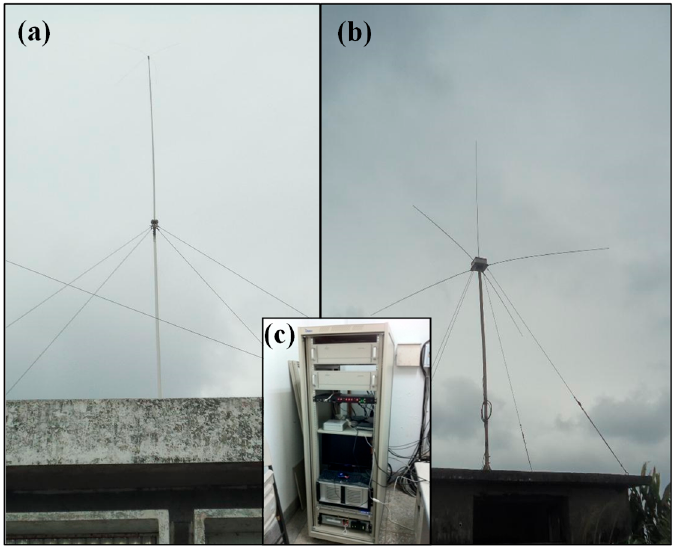
Figure 1. SeaSonde hardware equipment: ( a ) the transmitting antenna (Tx); ( b ) the receiving antenna (Rx), including a monopole and two cross-loop antennas; and ( c ) the central control system.